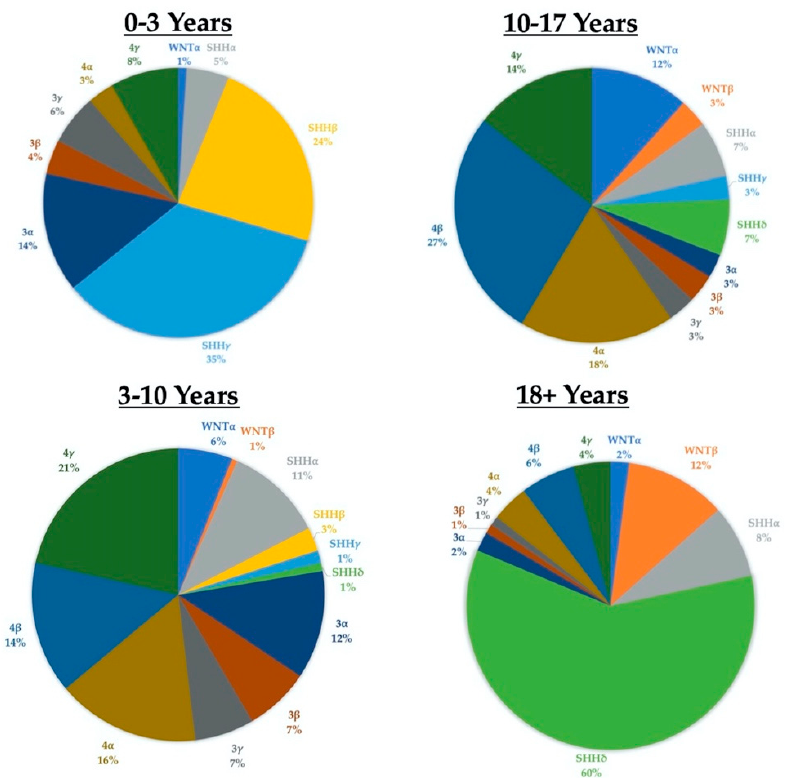
Figure 1. Medulloblastoma molecular subgroups and subtypes pie charts are based on data from Cavalli (2017). This series included 763 patients, of which 101 were adults [9] .